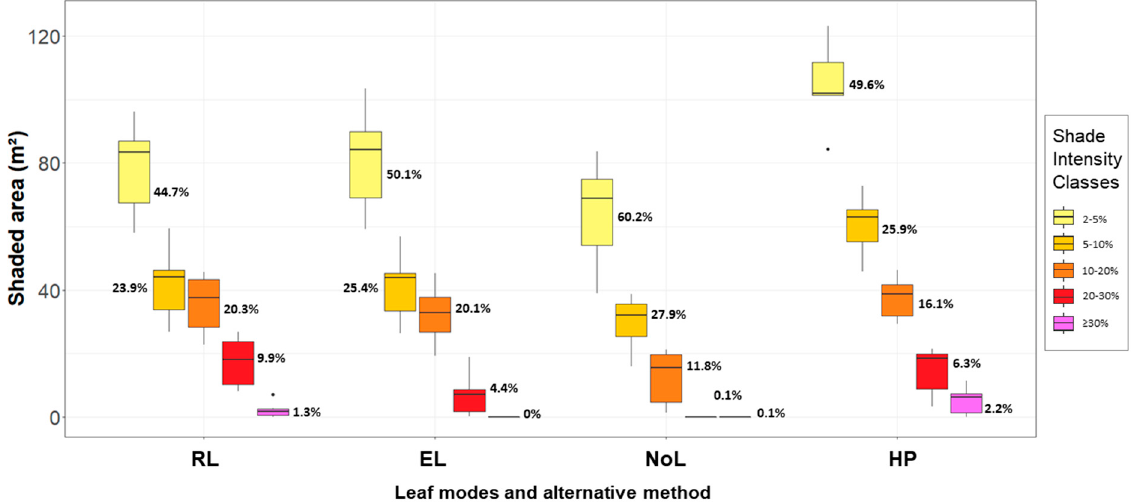
Figure 7. Shaded area (m²) per shade intensity classes of each leaf mode; the mean proportion of shade intensity classes is presented next to the coloured boxes.